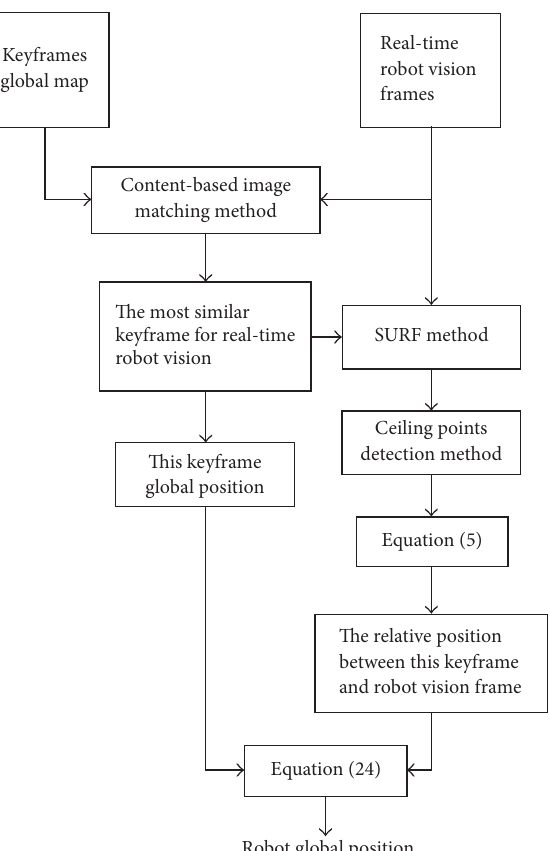
Figure 11: The image processing of robot localization.